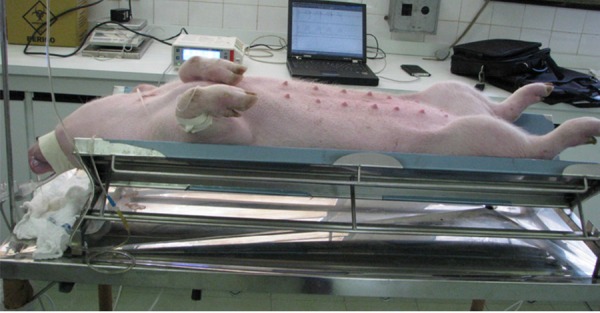
Overview procedure.